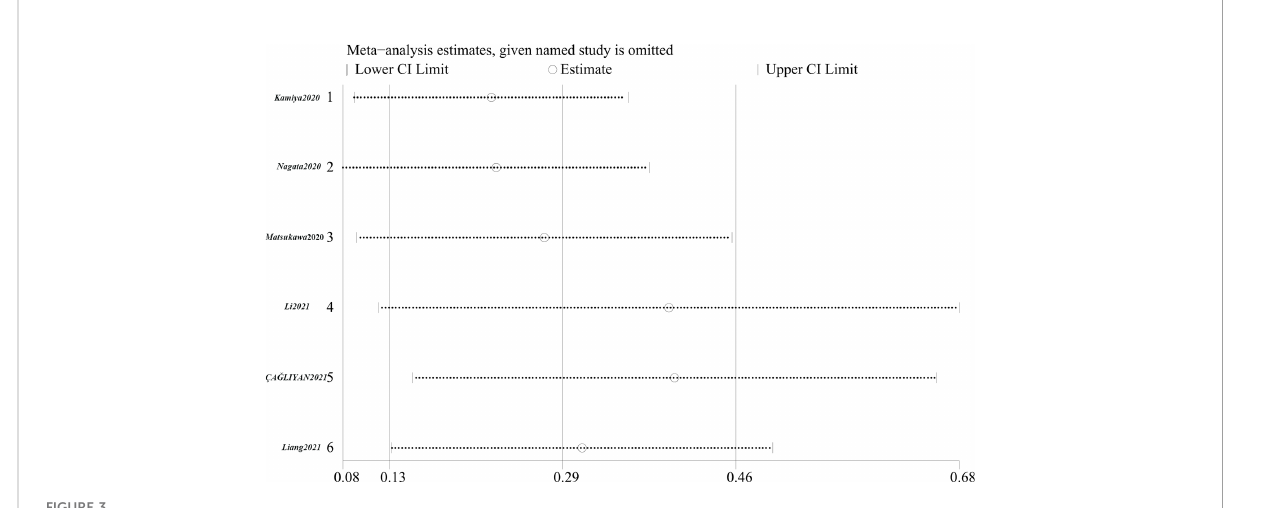
FIGURE 3 The sensitivity analysis of the prognostic role of high CONUT score on